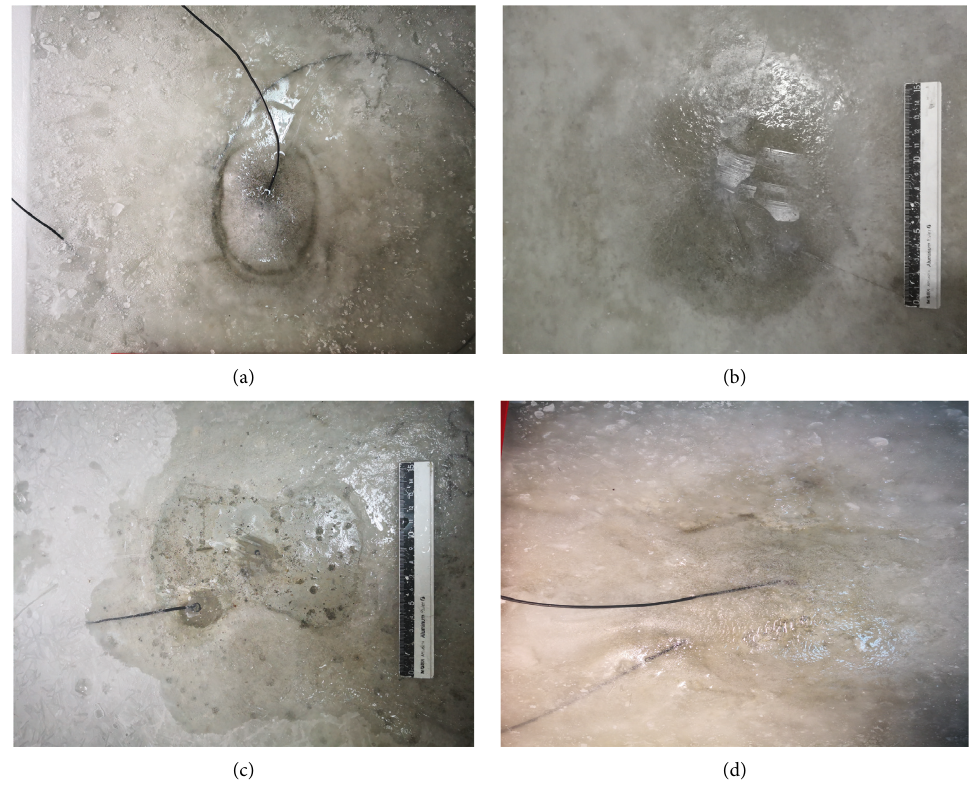
Figure 16: Deicing effect at different dosing levels. (a) PC. (b) 0.6CFC1. (c) 0.6CFC2. (d)